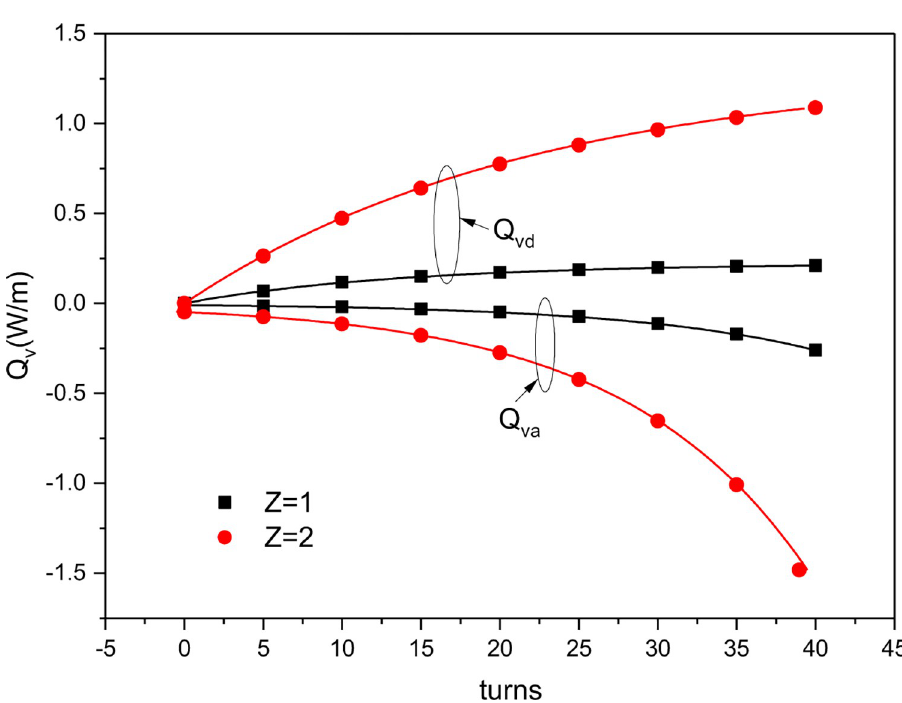
Fig 10. Changes in simulated PHCCs with the number ( Z ) and twist turns of the nitinol wires in one nitinol wire- stepping motor unit during continuous torsional refrigeration.